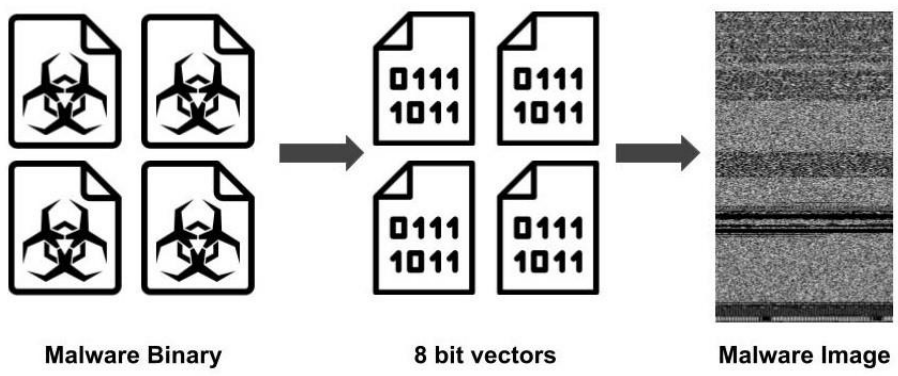
Figure 1. Process of creating a grayscale image from binary of a malware program. It can be visually verified that these images created from binary files have very strong visual interclass relationships and, vice versa, differs from the images of unrelated classes, which assures us that the image-based classification is a very representative method for this dataset. Figure 2 shows representative grayscale images of